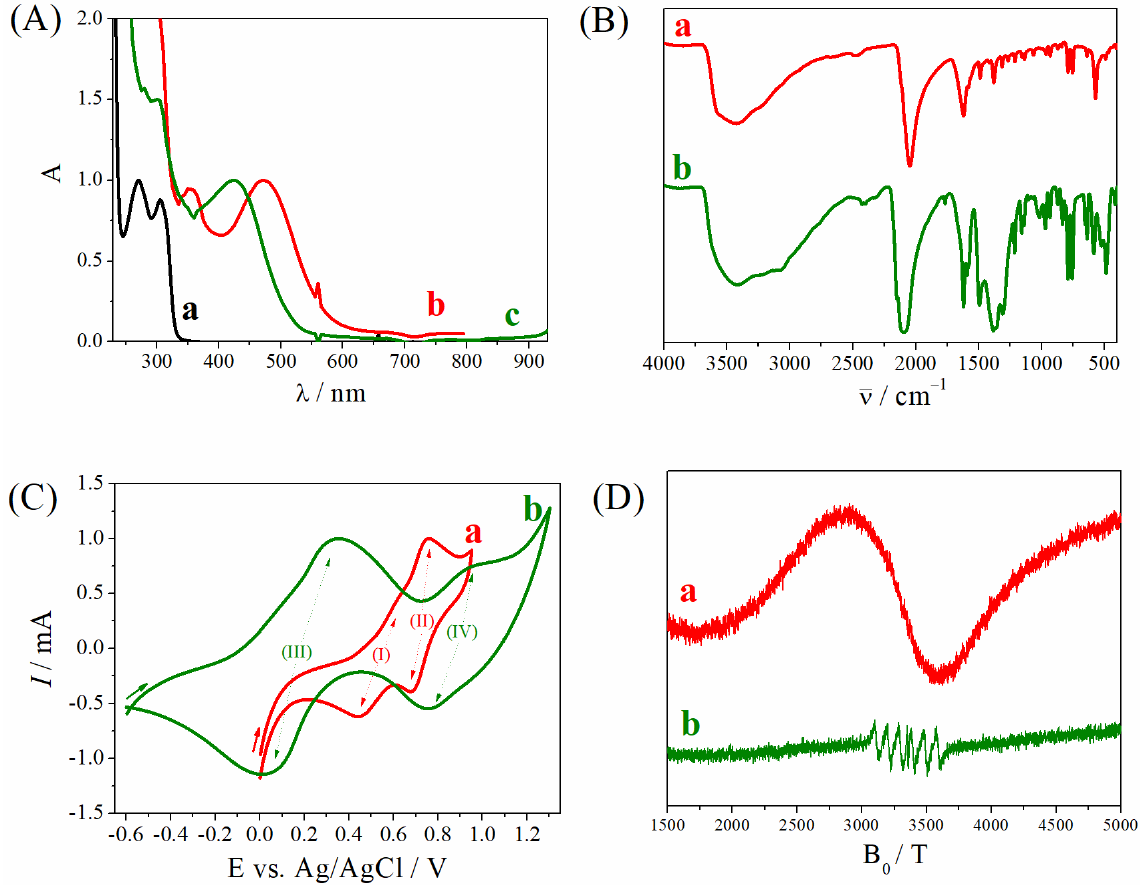
Figure 2. ( A ) UV-Vis spectra of (a) qnz, (b) PCF-qnz, and (c) PBA-qnz in aqueous solution. ( B ) Infrared absorption spectra of (a) PCF-qnz and (b) PBA-qnz. ( C ) Cyclic voltammograms of (a) PCF-qnz/CPE and (b) PBA-qnz/CPE with a scan rate of 25 mV s − 1 (supporting electrolyte: 0.1 mol L − 1 KCl). ( D ) EPR spectra in the X-band at room temperature of (a) PCF-qnz and (b) PBA-qnz, revealing the nature of the iron sites.